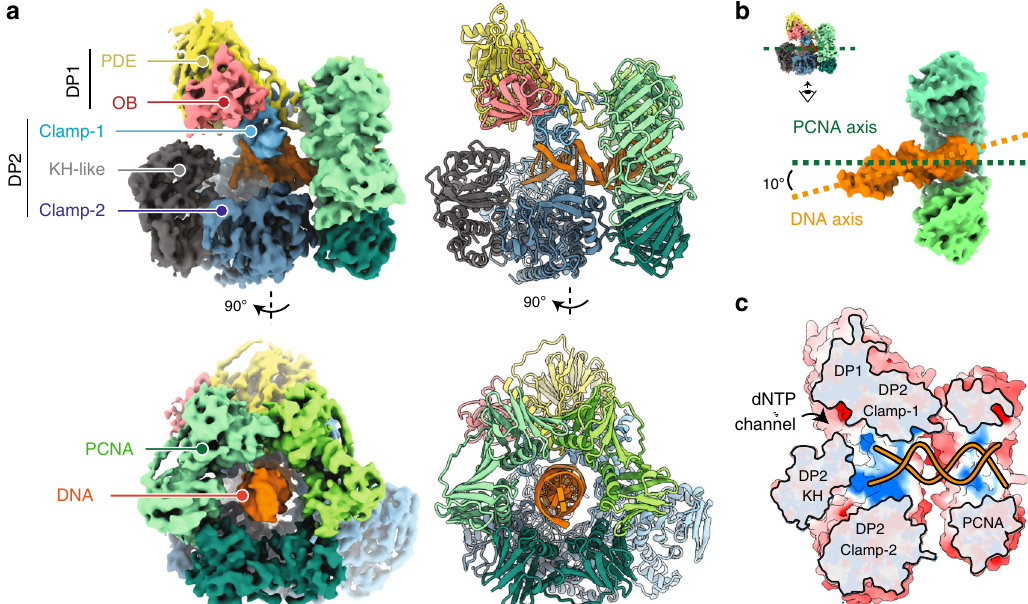
Fig. 1 Cryo-EM structure of the DNA-bound PolD – PCNA processive complex. a Two orthogonal views of the cryo-EM density map (left) and cartoon representations (right) of the DNA-bound PolD – PCNA complex. b Orientation of the DNA duplex with respect to the PCNA threefold symmetry axis. c Cutaway front view of the PolD – PCNA – DNA complex showing the electrostatic surface potential with negative, neutral, and positive charges represented in red, white, and blue, respectively.